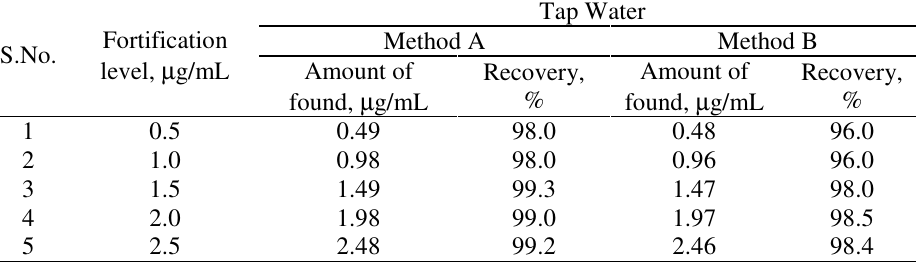
Table 3. Recovery of carboxin from fortified water samples